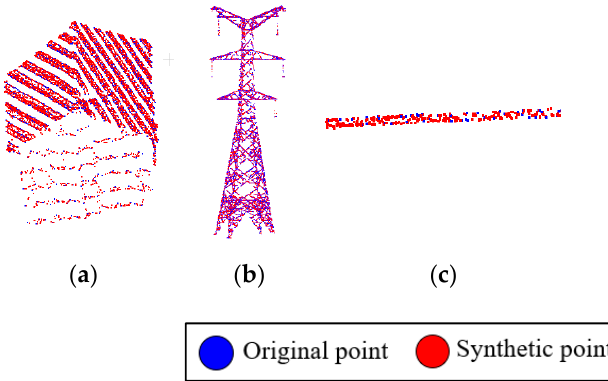
Figure 12. Oversampling results of the building, pylon and power line class: ( a ) Oversampled building, ( b ) oversampled pylon, ( c ) oversampled power line. The original points are colored with blue, while the synthetic points are colored with red.